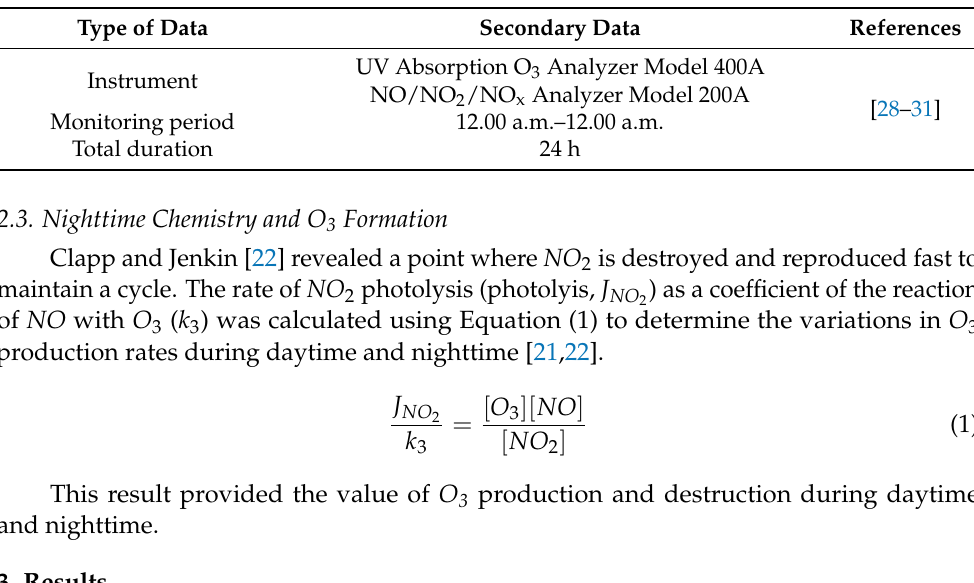
Table 2. Summary of data collection